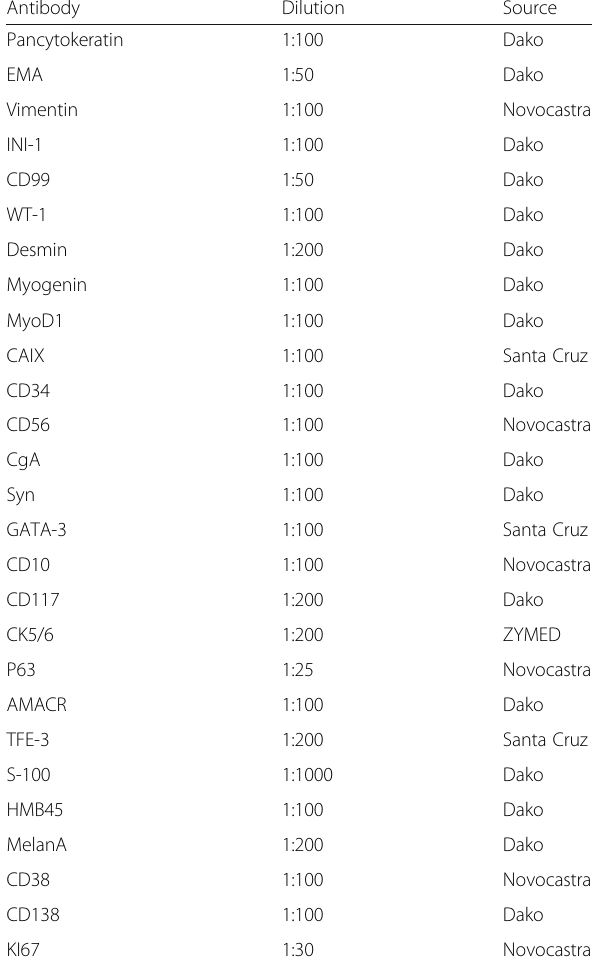
Table 1 Antibodies and dilutions used in the evaluation of malignant rhabdoid tumor in transplanted kidney